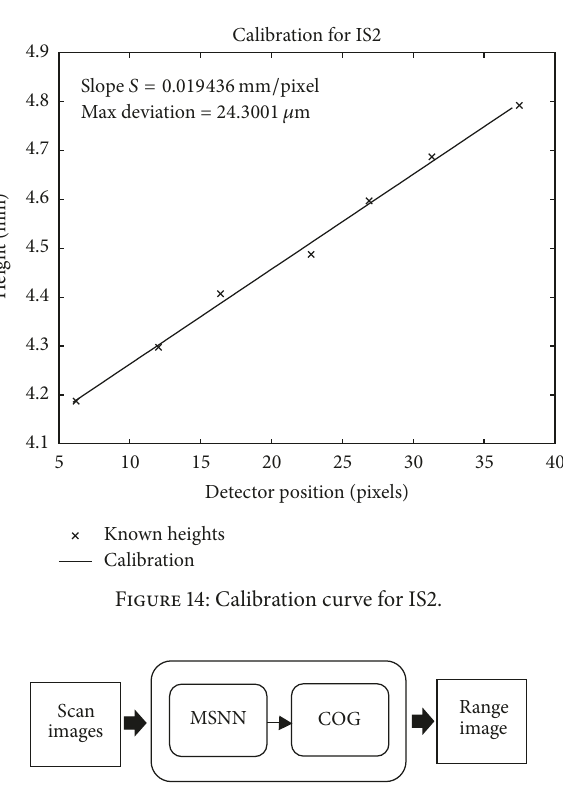
Figure 14: Calibration curve for IS2.